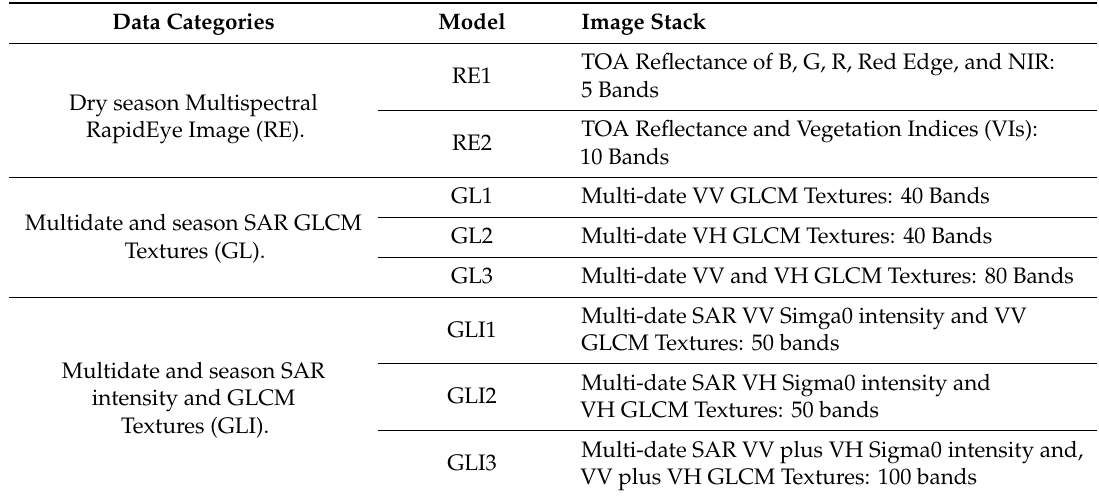
Table 3. The image stacks used to evaluate the Random Forest (RF) algorithm’s classification accuracy. Data Categories Model Image Stack Dry season Multispectral RapidEye Image (RE). Multidate and season SAR GLCM Textures (GL). Multidate and season SAR intensity and GLCM Textures (GLI).